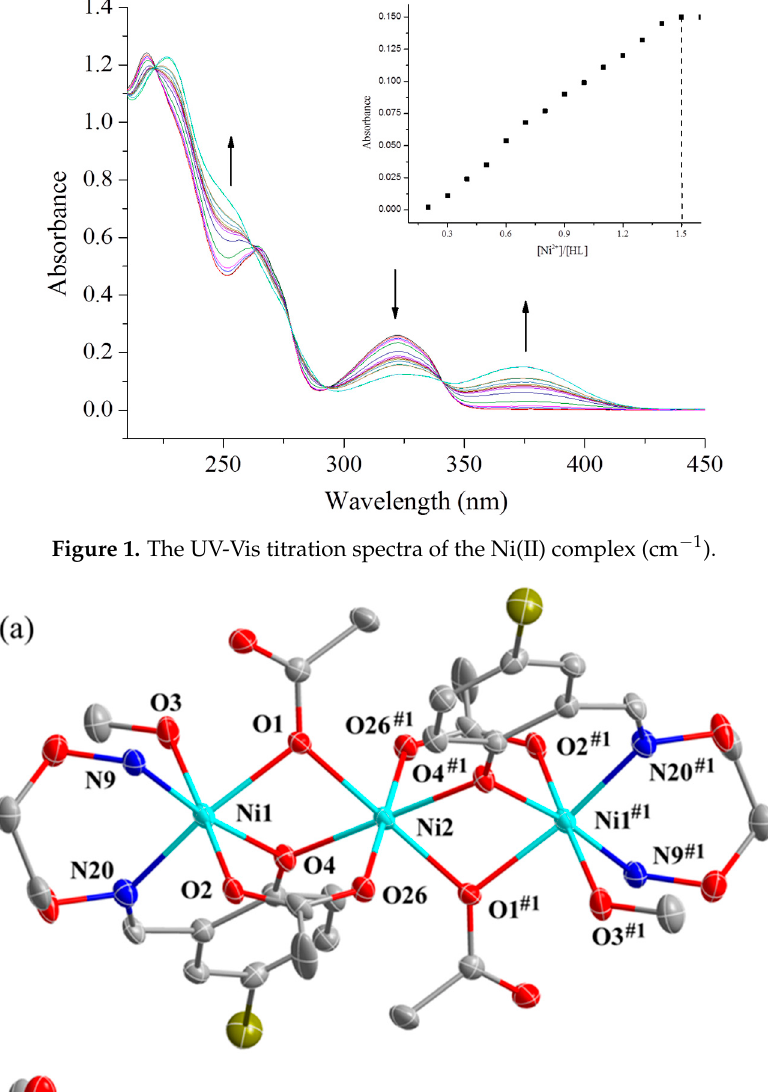
Figure 1. The UV-Vis titration spectra of the Ni(II) complex (cm − 1 ).